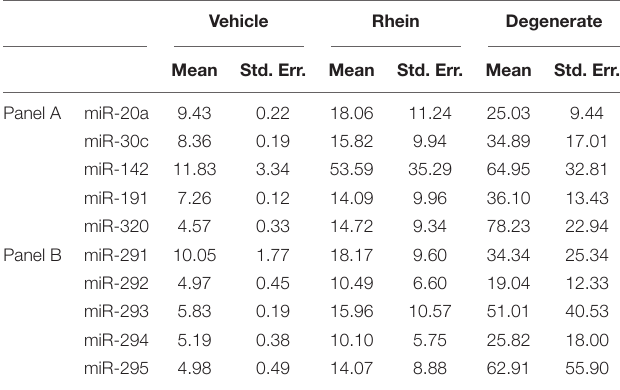
TABLE 3 | Calculated extracellular miRNA transcript microdroplet abundance expressed as a percentage of that found within whole embryo cohorts of various degrees of